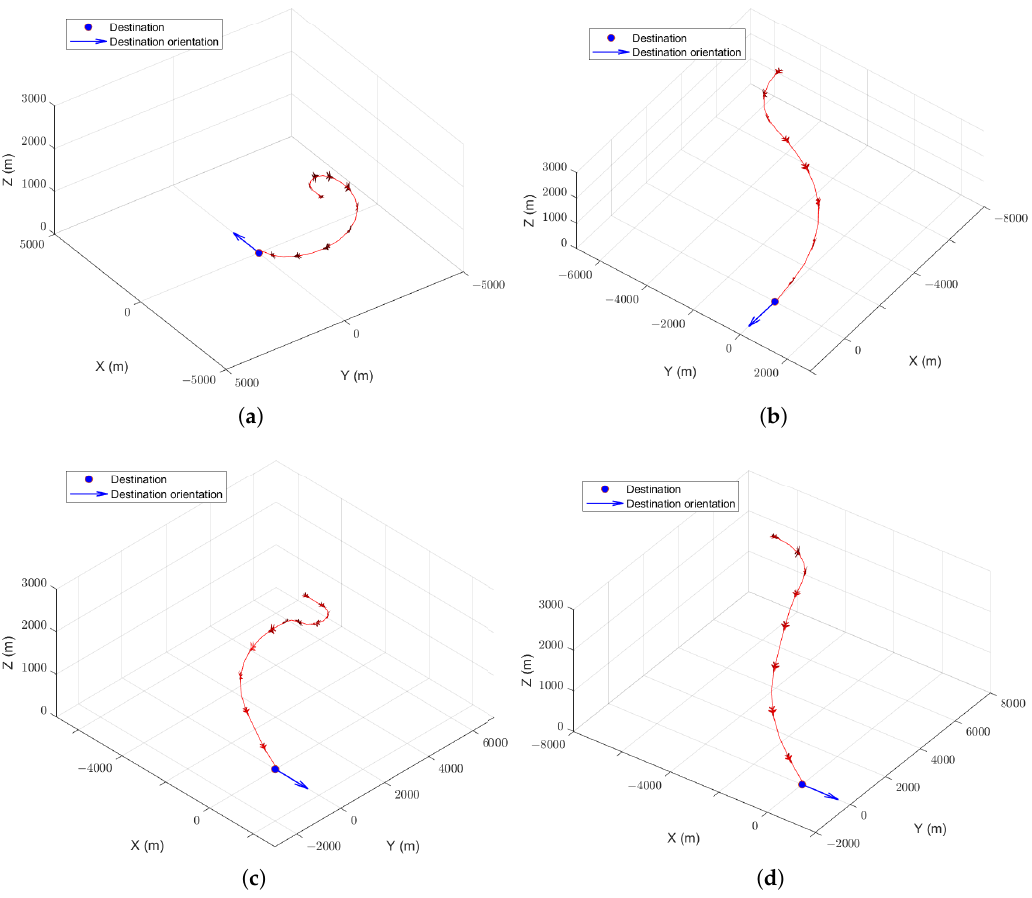
Figure 6. Trajectories in fixed-position destination scenario: ( a ) PPO, ( b ) PPO with continuous-action reward function, ( c ) PPO with position reward function and ( d ) PPO with both reward